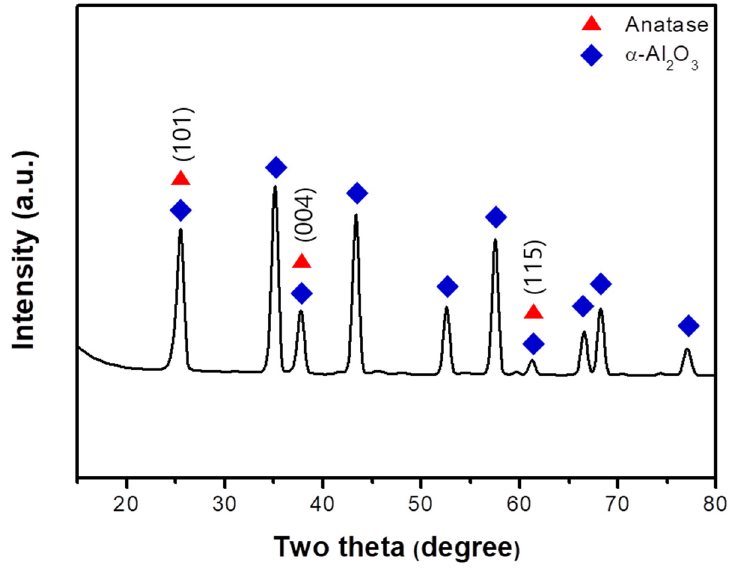
Figure 6. X-ray diffraction (XRD) pattern of the POEM-directed TiO 2 film on the Al 2 O 3 membrane.